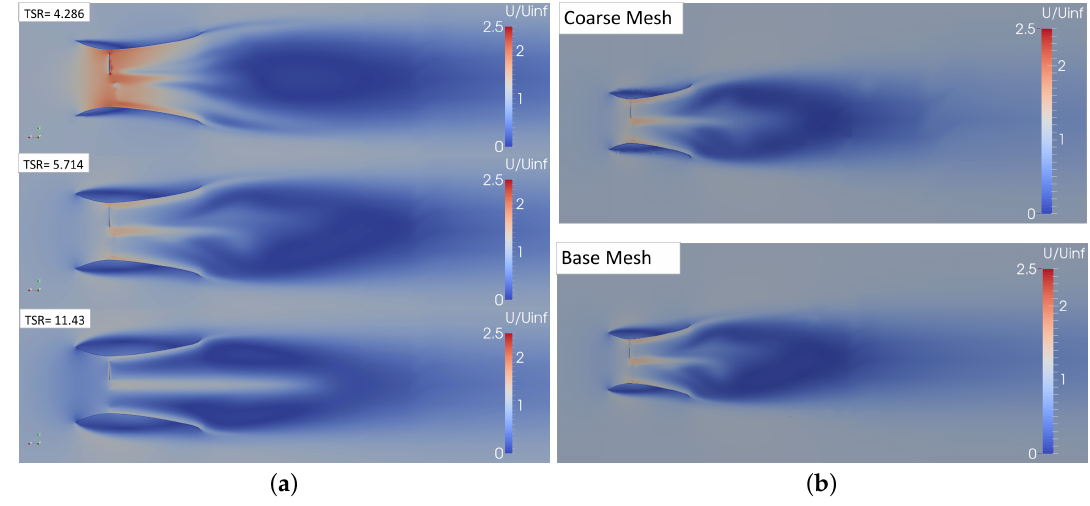
Figure 7. Flow visualization of ducted turbine. ( a ) Velocity field of ducted turbine at different TSRs. ( b ) Coarse mesh flow and base mesh flow at TSR = 5.714.